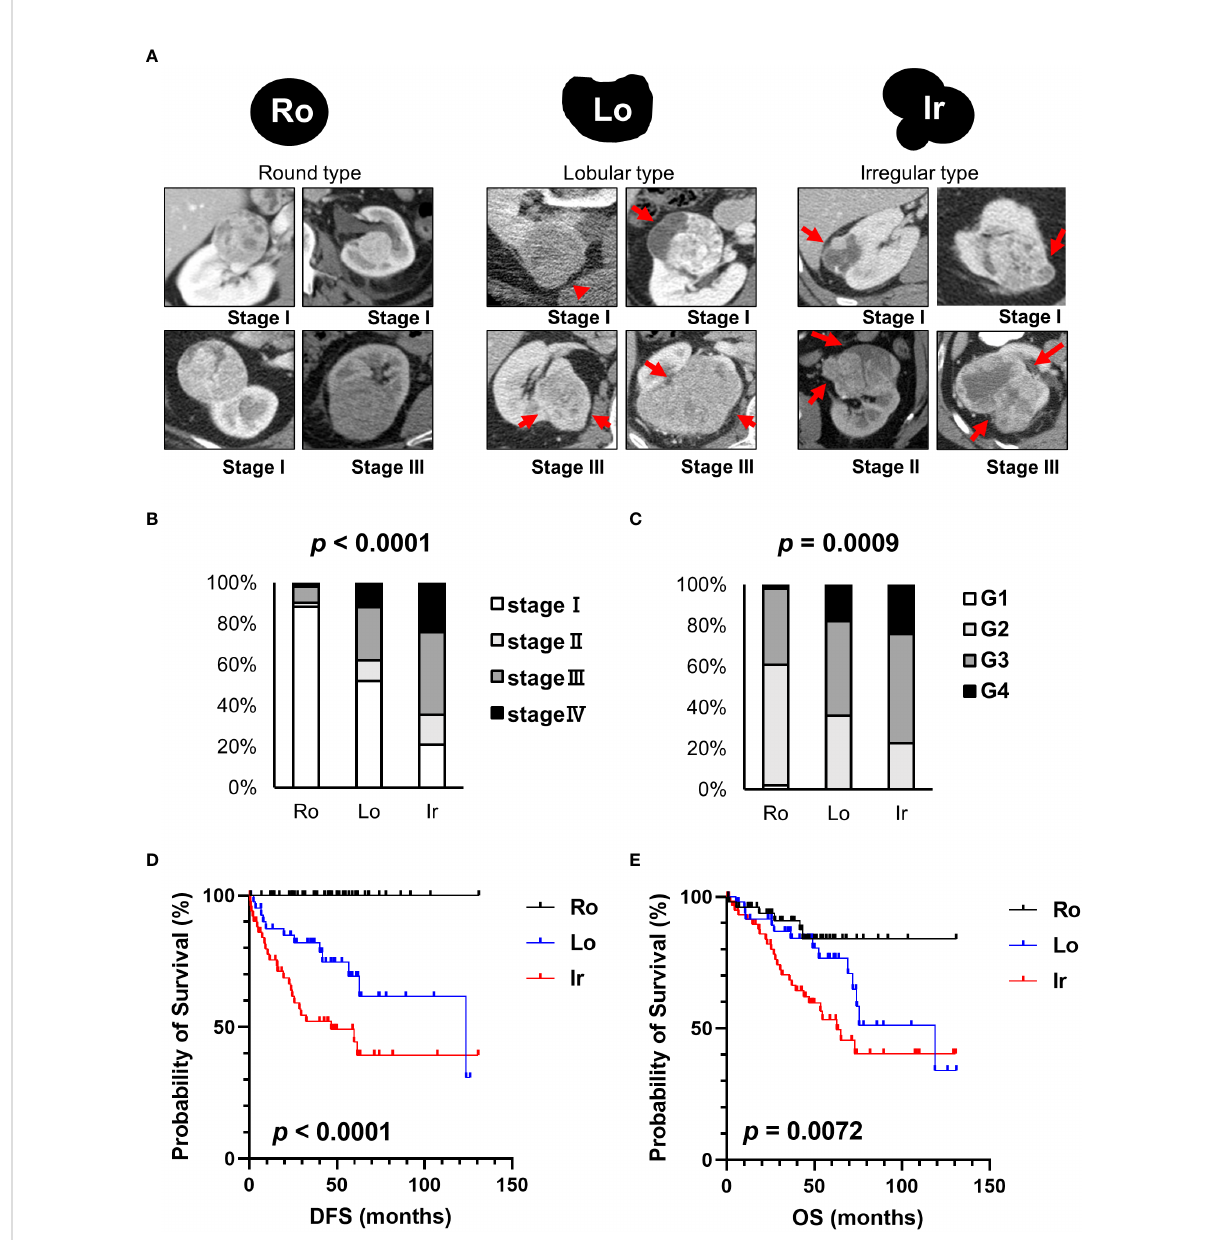
FIGURE 1 Clinical characteristics of each RM in TCIA datasets. (A) Schematic images and representative CT scans of the round, lobular, and irregular types from TCIA datasets. (B) The relationship between each RM and stage. (C) The relationship between each RM and grade. (D) Comparison of disease-free survival (DFS) between each RM type. (E) Comparison of overall survival (OS) between each RM type. Ro, round type; Lo, lobular type; Ir, irregular